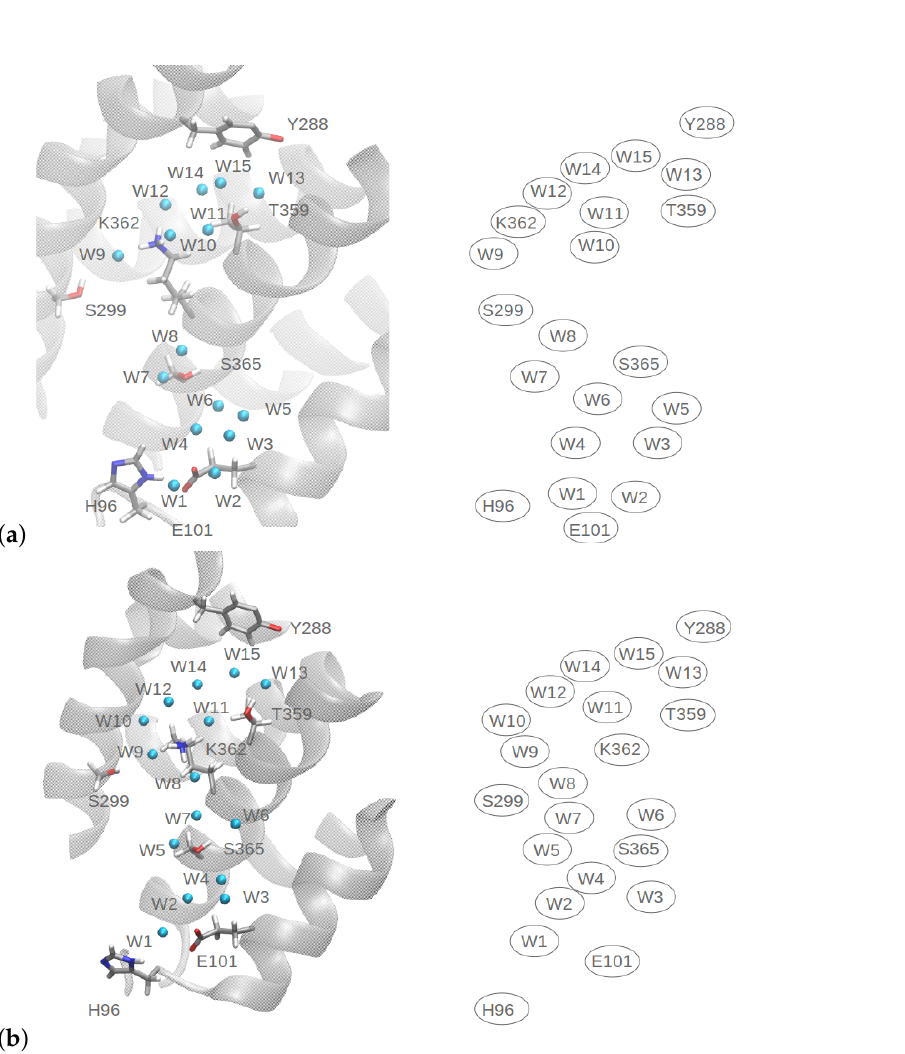
Figure 1. Model of the K-channel in cytochrome c oxidase: ( a ) based on a snapshot with K362 in an “up” position and ( b ) based on a snapshot with K362 in a “down” position. Left : protein residues considered in the hydrogen-bond and proton transfer analyses. Water molecules are shown as cyan spheres and labeled according to their position (height) in the channel. Right : Schematic representation of the channel, representing the residues of interest as ellipses and labeled as in the snapshots. Snapshots are not aligned with respect to each other but rather rotated such that an optimal view of the water molecules is